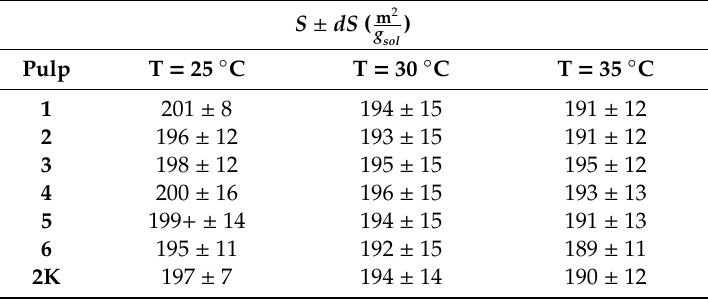
Table 4. Specific surface area of pulps at 25, 30 and 35 ◦ C.